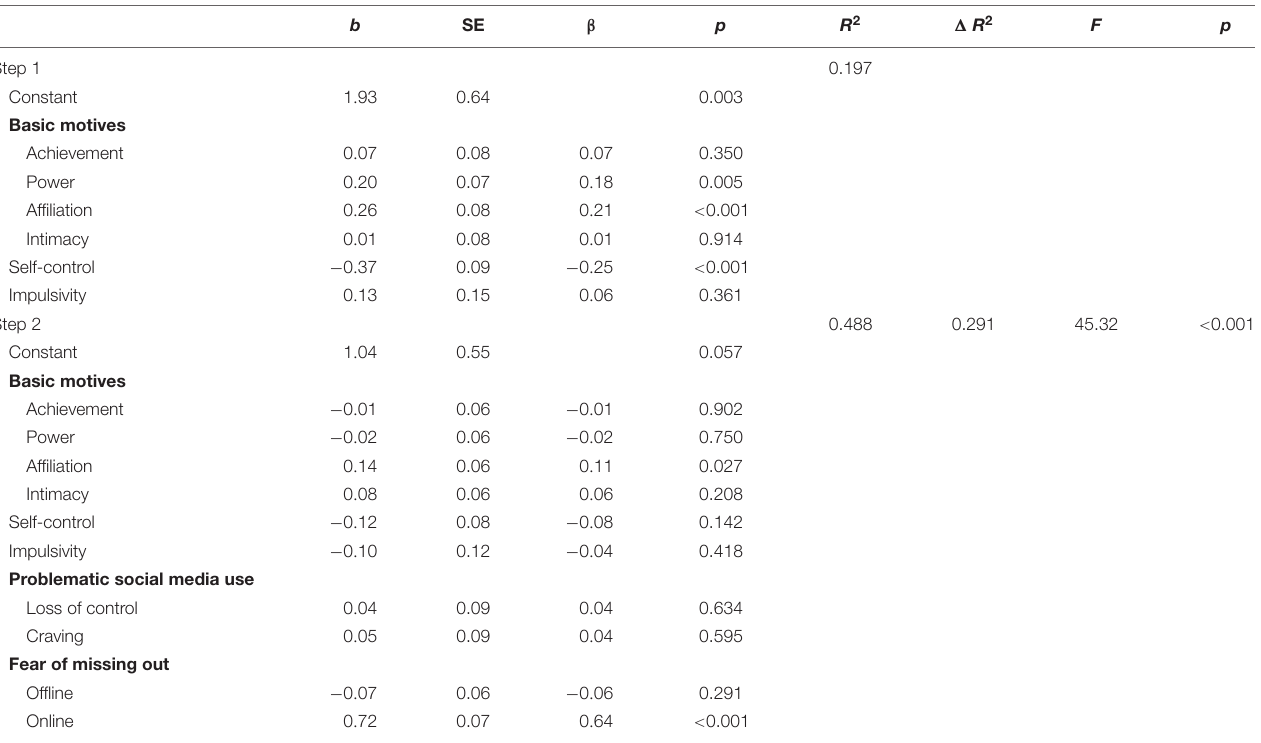
TABLE 7 | Hierarchical regression examining the effect of traits on social